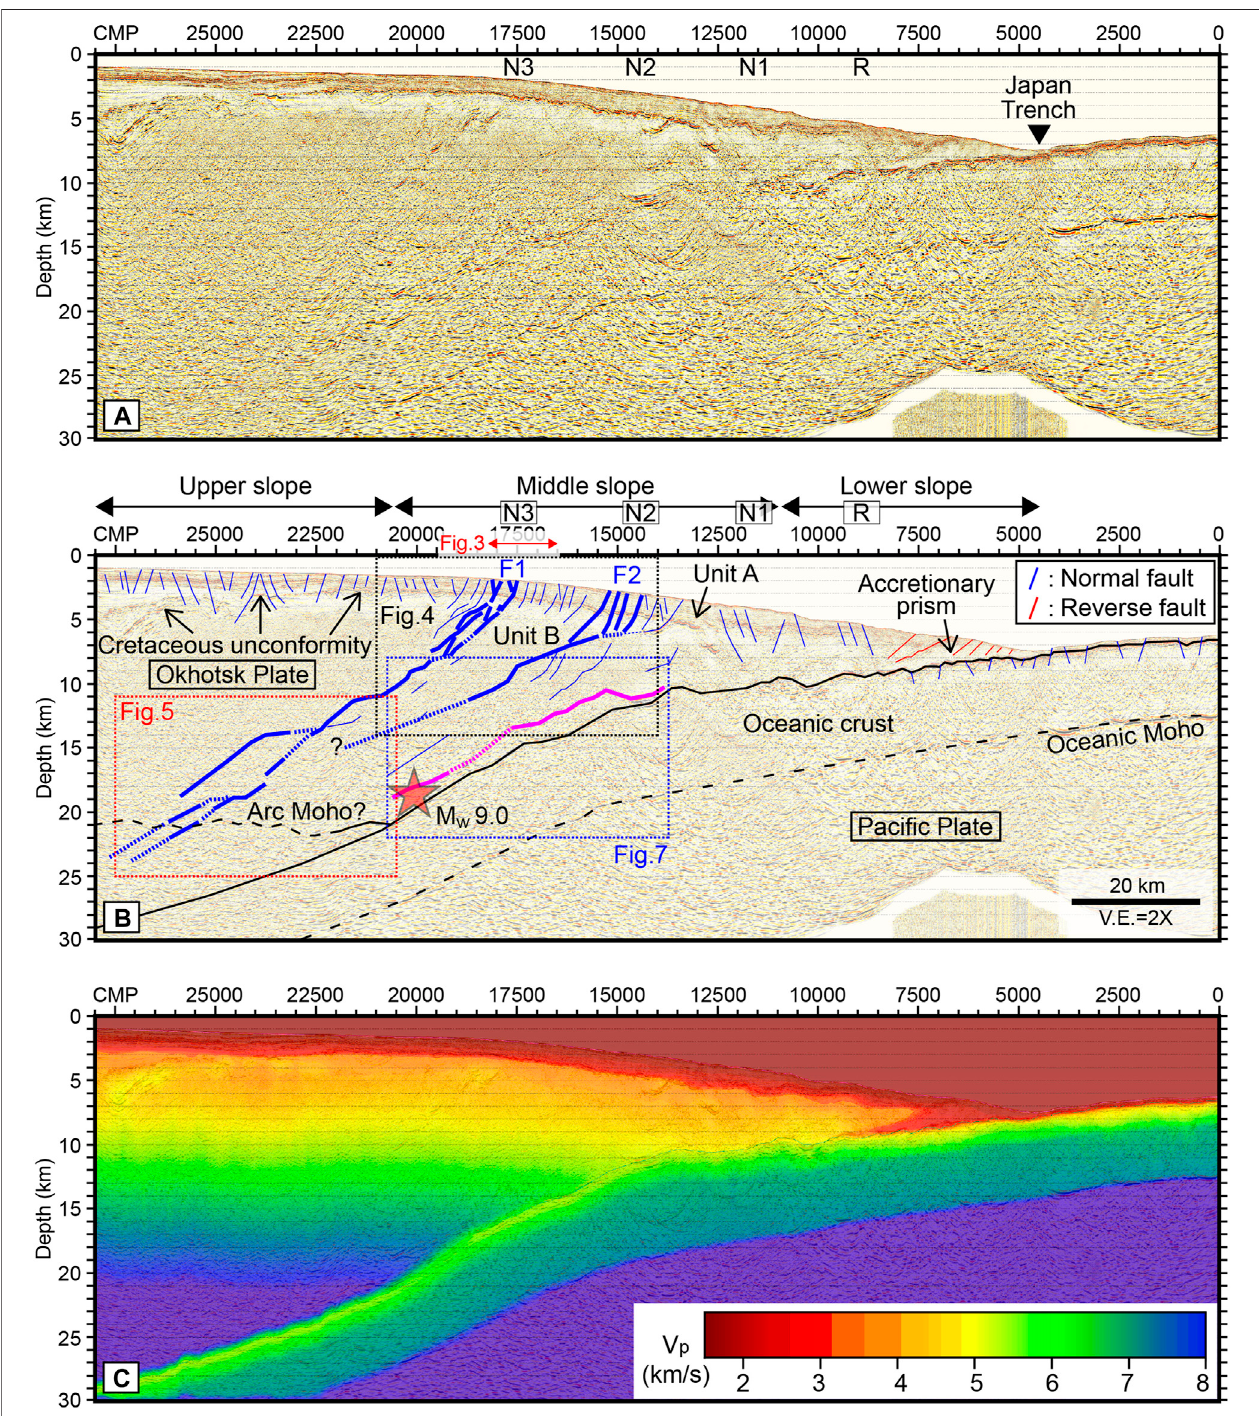
FIGURE 2 | Pre-stack depth migrated (PSDM) seismic pro fi le, interpretation, and V p model for the PSDM on line D6. (A) Uninterpreted PSDM pro fi le. Locations of the helium isotope anomaly sites (Sano et al., 2014) are displayed: N3, N2, N1, and R. (B) Interpreted PSDM pro fi le. The red star marks the hypocenter of the 2011 Tohoku mainshock (M w 9.0). Normal and reverse faults are denoted respectively by thin blue and red lines. A thin red line below site N3 in the middle slope region marks the SBP line depicted in Figure 3 . It is noteworthy that landward-dipping normal faults (thick blue F1 and F2 below sites N3 and N2, respectively) and a potential shear zone (thick pink) develop in the middle slope region. Thin black, red, and blue dotted boxes are enlarged respectively in Figure 4 , Figure 5 , and Figure 7 . (C) V p model overlaid by the PSDM pro fi le.